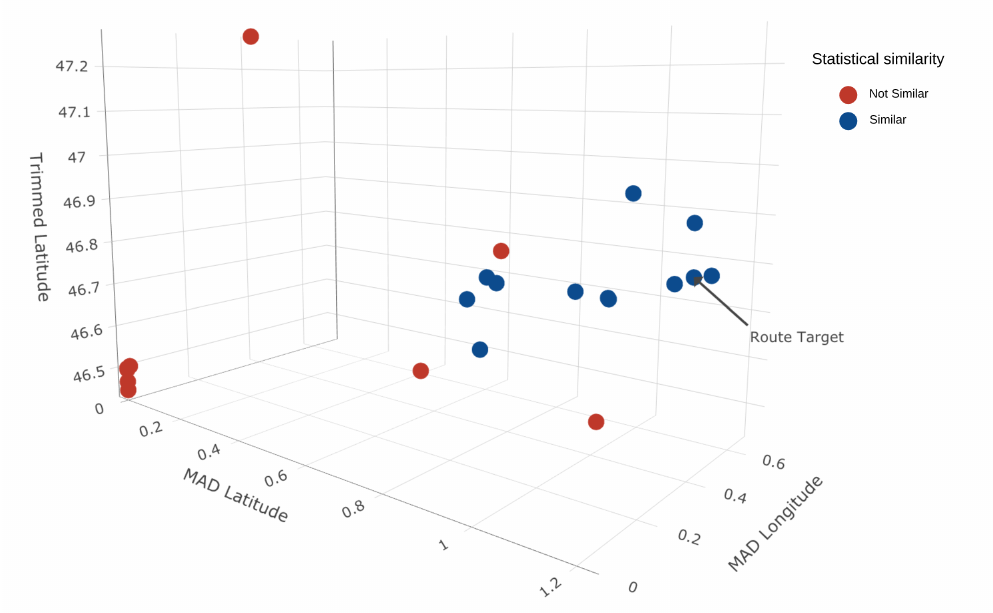
Figure 8. Cluster discovered using DBSCAN. Those routes in the group (tagged as Similar) have a similarity in statistical properties and help predict and estimate the